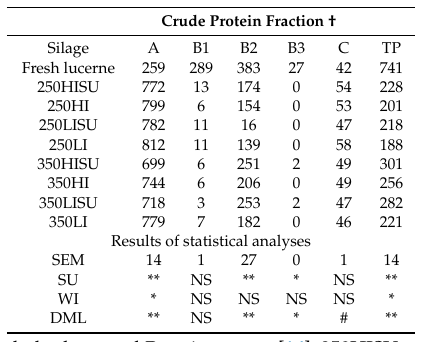
Table 2. Effect of sucrose addition (SU), wilting intensity (WI), and dry matter level (DML) on crude protein (CP) fractions (g kg − 1 CP) and true protein content (g kg − 1 CP) in lucerne silages (fresh lucerne values are provided as ease for